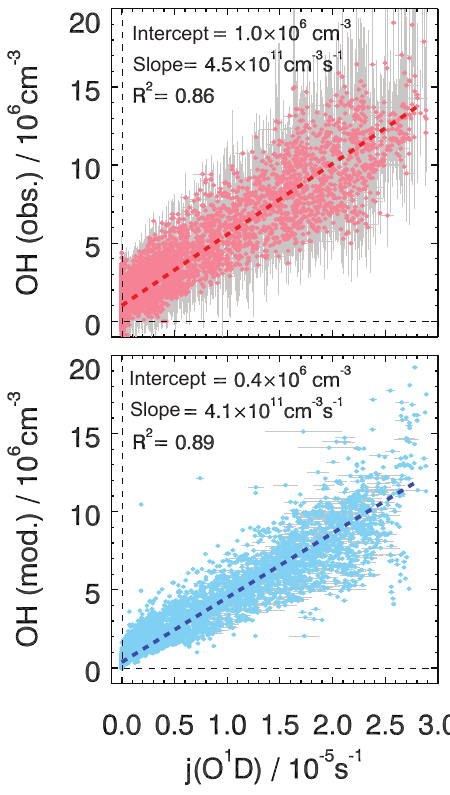
Figure 7. Correlation between j ( O 1 D ) and measured (upper panel) and modeled OH (lower panel). A linear fit is applied which takes errors in both measurements into account.